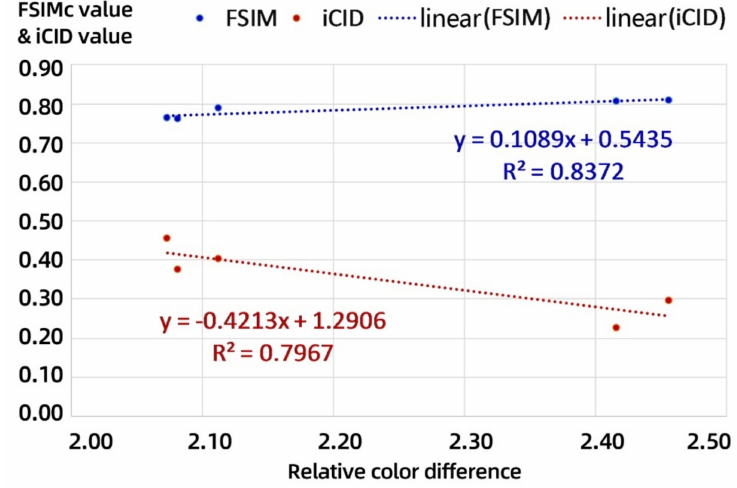
Figure 5. Linear fitting equations for specific color samples on all test